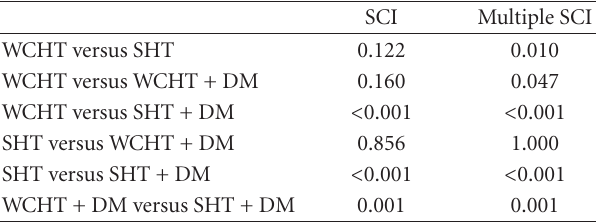
Table 1: P -values for the comparisons of 4 groups in Figure